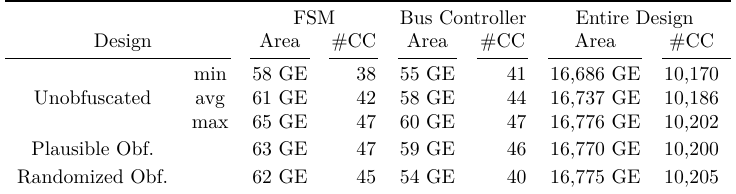
Table 4: Size comparison of the defensive applications of Doppelganger. Area includes all cells of the module, #CC denotes the number of combinational cells